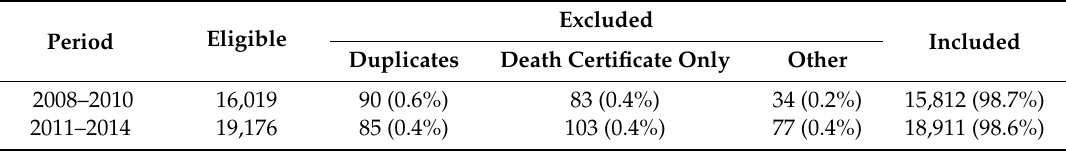
Table 1. Number of diagnoses of primary malignant neoplasms from breast cancer for women diagnosed between 2008 and 2010 and between 2011 and 2014 in